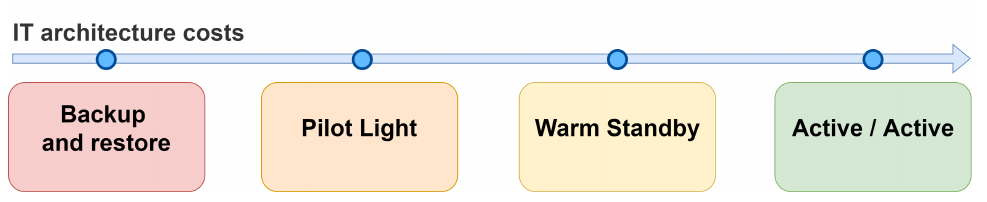
Figure 2. Disaster recovery